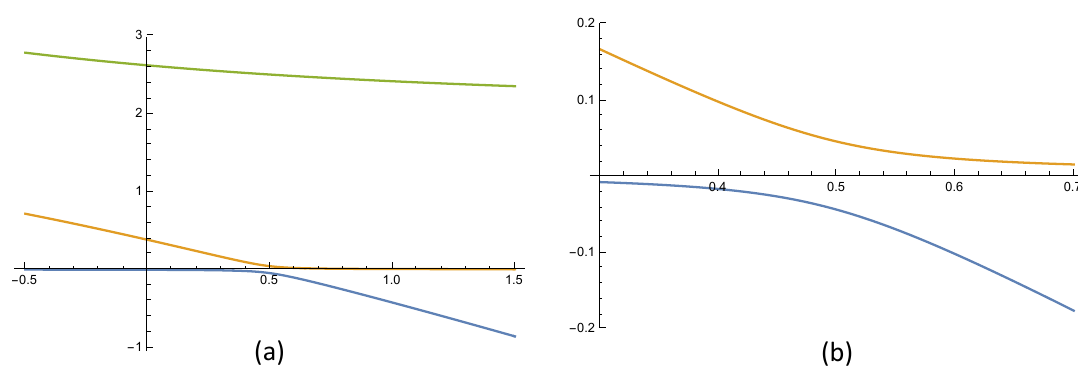
Figure 8 . N f = 2. (a) Evolution of the three eigenvalues as one varies (cid:22) 2 =a for b = 0 : 1 and (cid:22) 2 = 2 (cid:22) 2 . One of the three eigenvalue always lies much higher than the other two and is not much 2 1 a(cid:11)ected by the axion. (b) Blow up of the lower part of the (cid:12)gure showing the repulsion (and mixing) of the two lower eigenvalues.